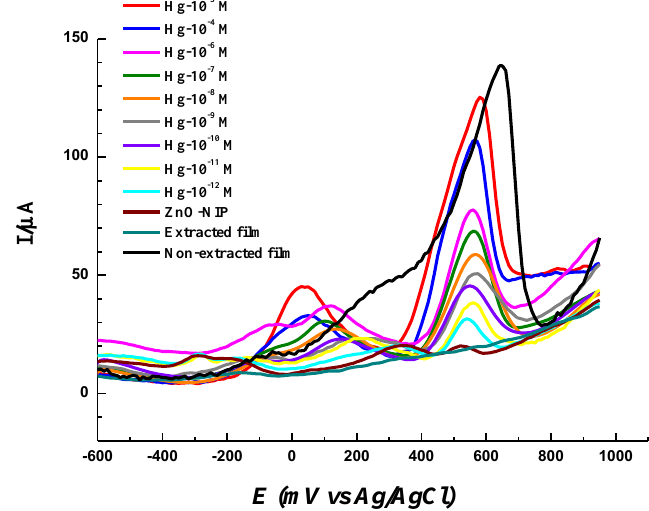
Figure 10. Follow-up of peak current variations (determined from SWV measurements in H 2 O/KCl 0.1 M solution) according to the potential. Conditions: E-pulse: 0.01 V, E-step: 0.01 V, frequency: 25 Hz, equilibration time: 2 s.